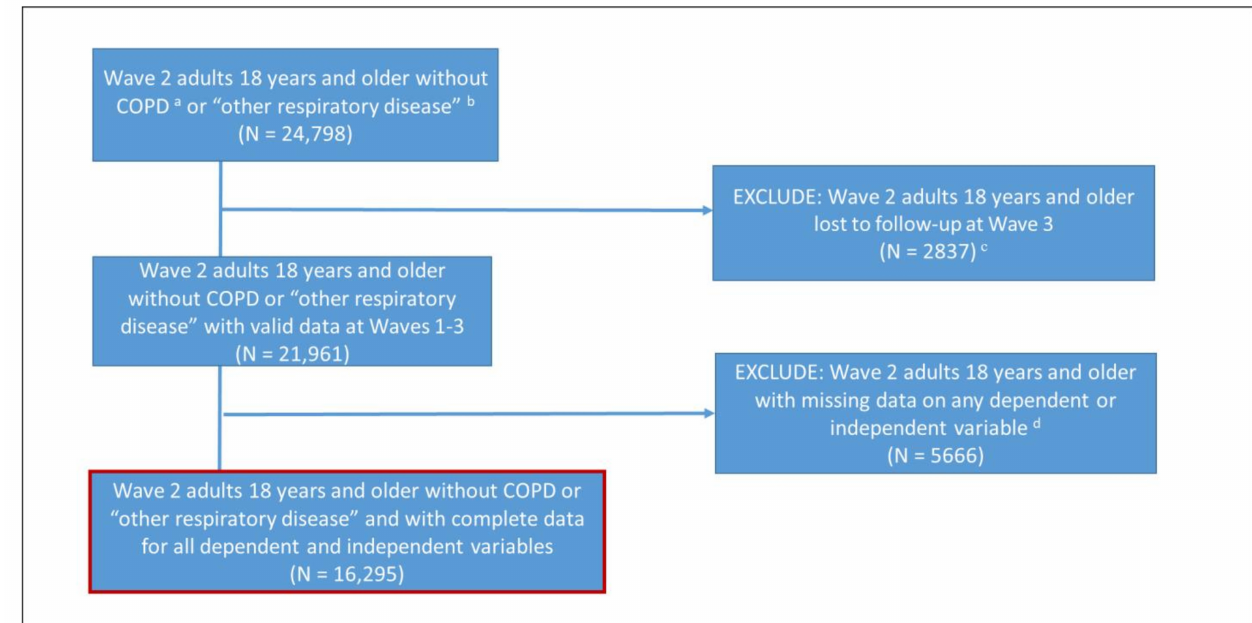
Figure 1. Main analytic sample determination. This figure illustrates the sample determination from the Population Assessment of Tobacco and Health Study for the main analyses that this validation will be used as described in the Materials and Methods of the manuscript. Some functional outcome analyses have additional variables that reduce the sample for those analyses further due to missingness. a Chronic obstructive pulmonary disease. b Other non-asthma respiratory diseases. c Weights adjust for non-response. d Dependent variables include Respiratory Symptom Index at Waves 2 and 3. Independent variables include tobacco product use at Waves 2 and 3 along with Wave 2 determinations of asthma, cigarette pack years, age, sex, ethnicity/race, education, income, congestive heart failure, diabetes, cancer, heart attack, body mass index, marijuana use, past week second-hand smoke exposure, regular use of Beta Blockers, Angiotensin Receptor Blockers, or Ace Inhibitors, and Wave 1 determination of